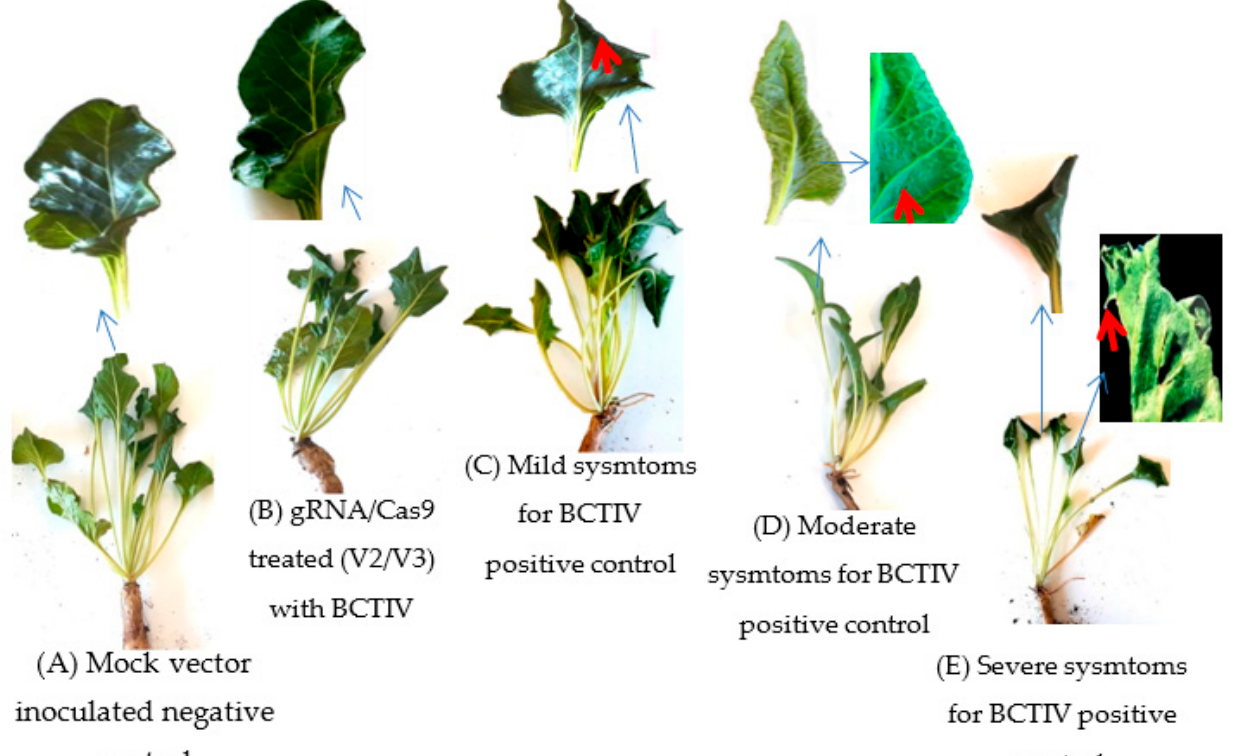
Figure 4. Beet curly top disease symptoms on sugar beets due to the agroinoculation of BCTIV. Mock vector and gRNA/Cas9 inoculated plants represented no disease symptoms ( A , B ). On the other hand, BCTIV agroinoculated positive control plants revealed mild leaf curling and thicker vein formation on the leaves ( C ), while most of them indicated moderate ( D ) or severe ( E ) disease symptoms such as dwarfed, crinkled, and completely rolled leaves with spike-like outgrowths (Red arrows). Almost all the gRNA/Cas9 treated sugar beets survived, and the rate of plants having moderate to severe BCTD symptoms decreased to 0–35% (Table 1). Most of the gRNA/Cas9 treated plants did not revealed any BCTD symptoms. Among the BCTIV positive control plants, only two sugar beets had no BCTD symptoms, while the rate of healthy plants increased to 45–85% in gRNA/cas9 treated counterparts. Among the single gRNA/Cas9 treated plants, the highest number of healthy plants (85%) was recorded for the gRNA/Cas9 construct targeting the overlapping region between movement and ssDNA regulator (V2/V3) (Table 1). The reduction in plant biomass for the BCTIV-inoculated positive control plants was estimated to be 68% compared to mock vector inoculated ones. The same comparison for the gRNA/Cas9 treated sugar beets decreased and ranged between 13% and 45% (Table